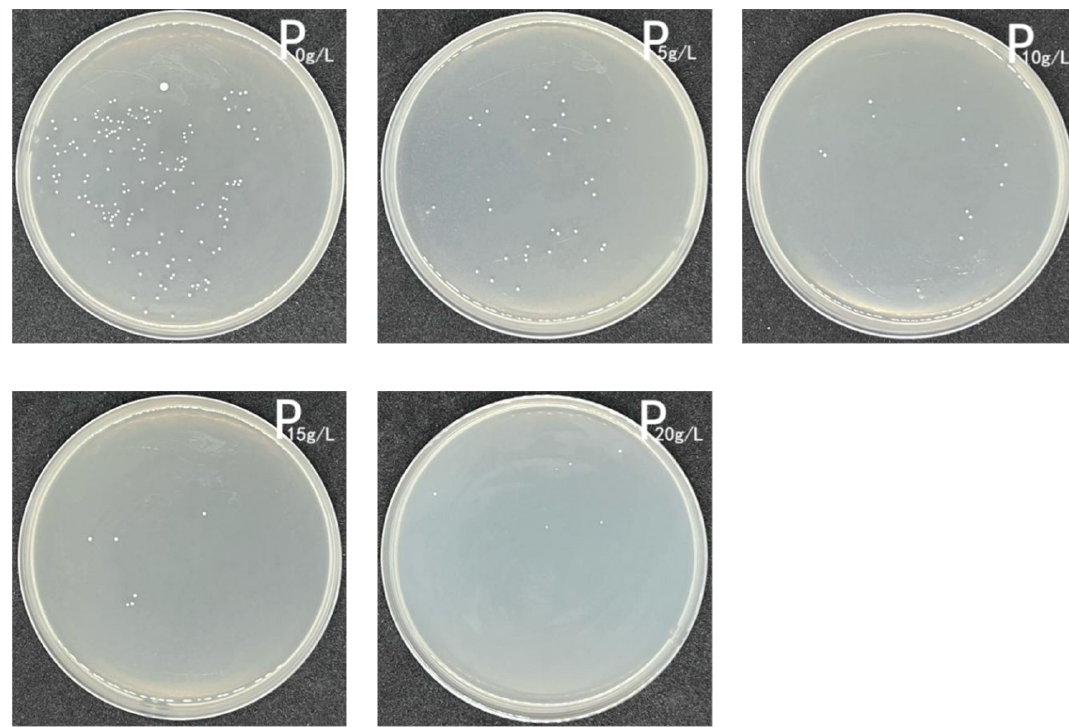
Figure 14. Inhibition of C. albicans by untreated co tt on and antimicrobial co tt on.